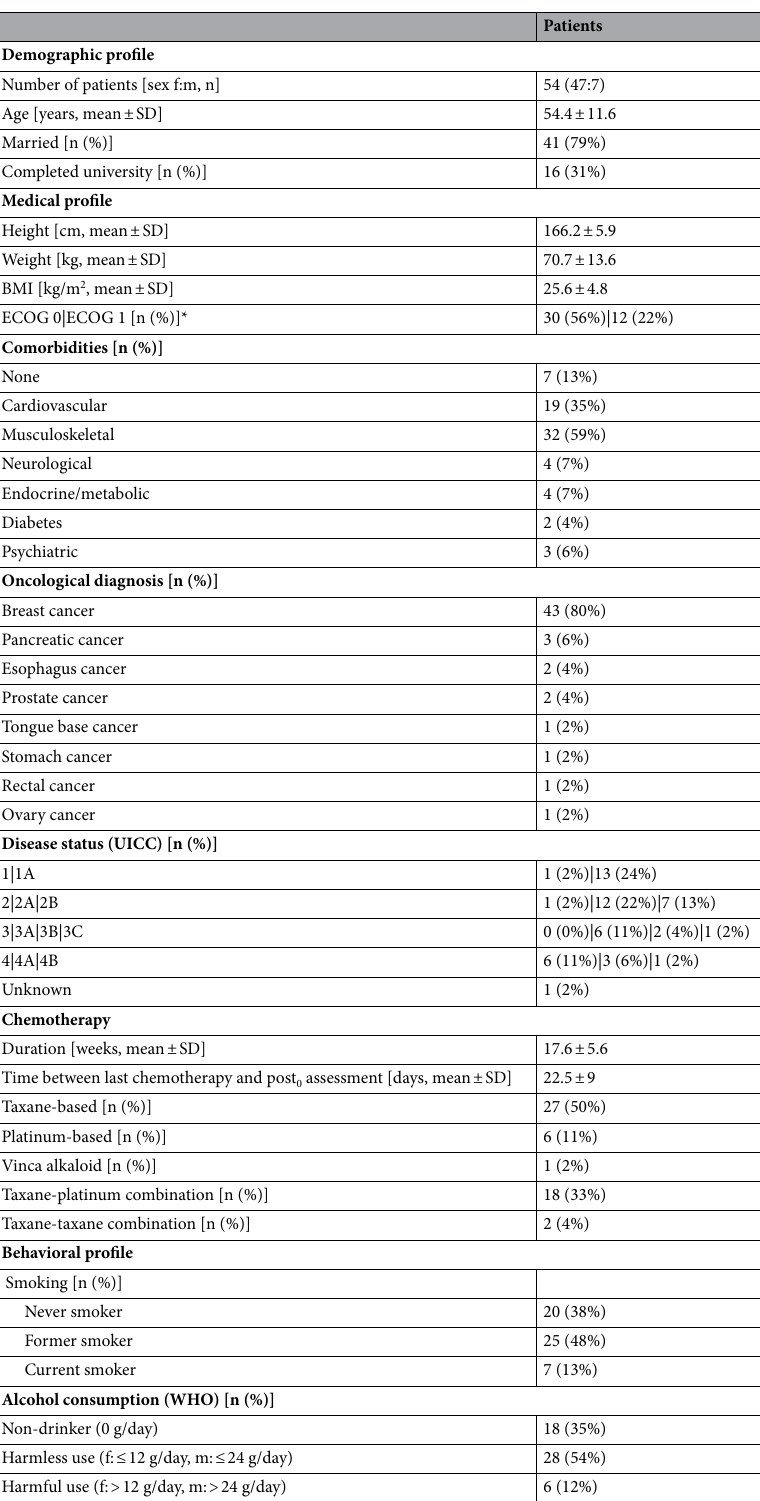
Table 1. Patient characteristics. post 0 , assessment point at completion of neurotoxic chemotherapy. *Patients with an ECOG status ≥ 2 were not included in our study. Therefore, the missing ECOG values (n = 12; 22%) are also in the range of ECOG